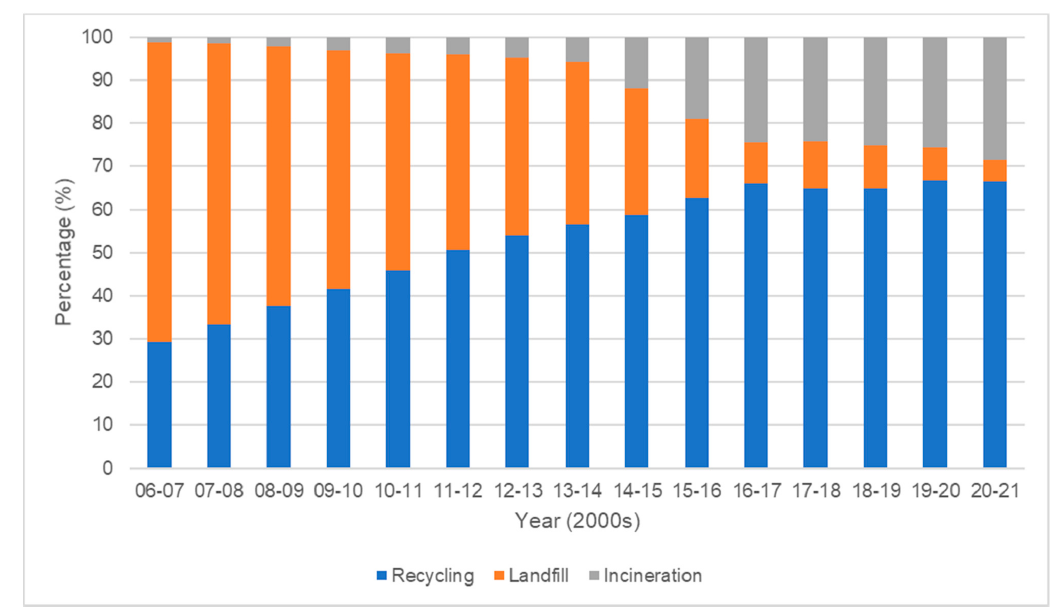
9 of 24 Figure 5. Total incinerated waste per person (kg) per quarter; Welsh average. Source: